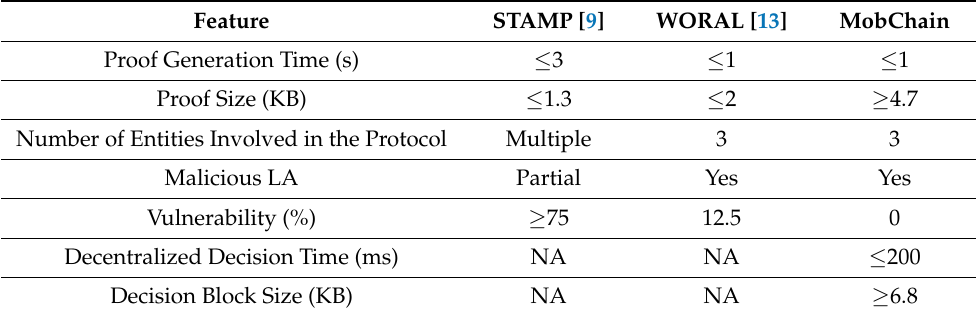
Table 3. Comparison with existing techniques.